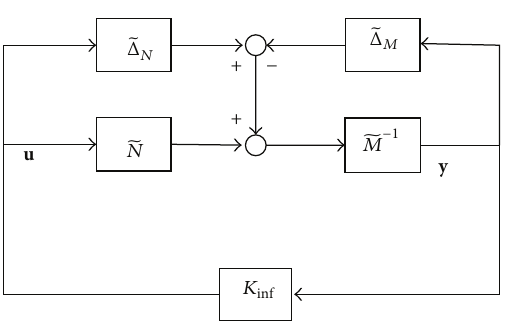
Figure 3: Standard presentation of 𝐻 ∞ control